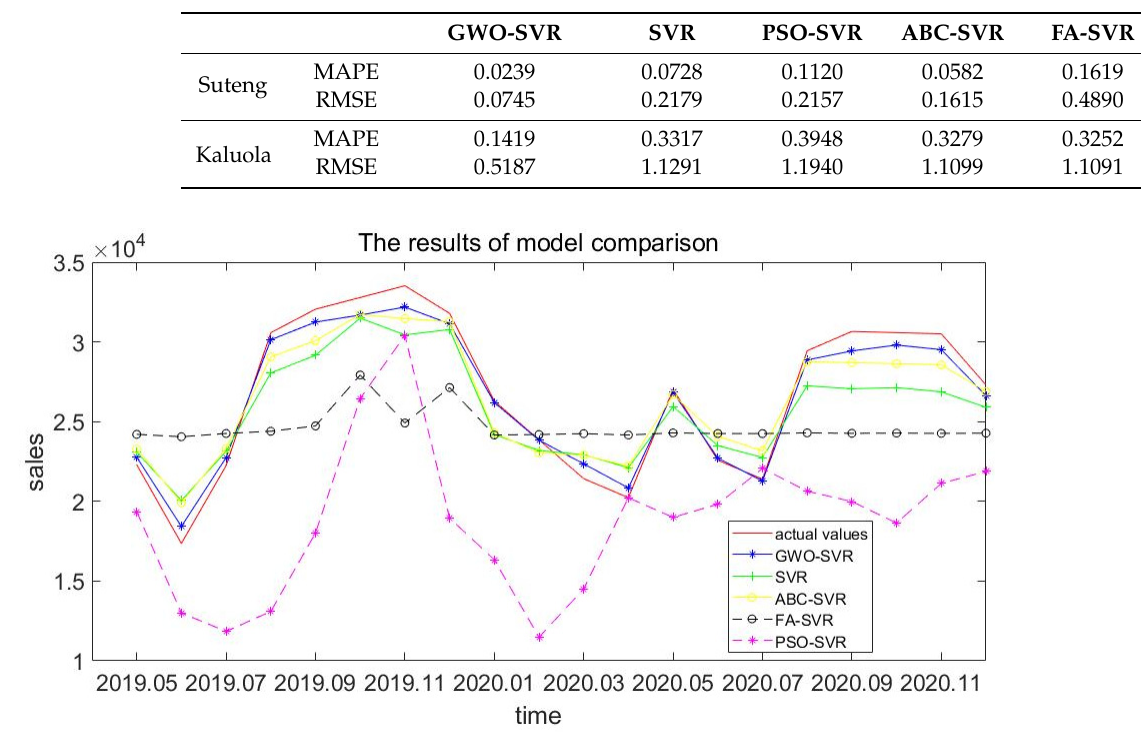
Figure 5. Model comparison results of Suteng.